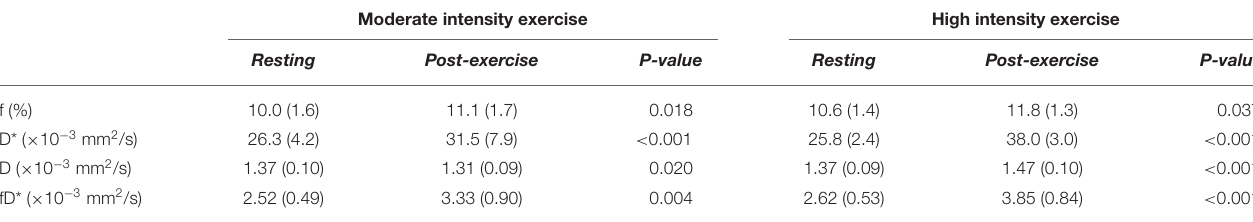
TABLE 2 | Results of IVIM coefficients at rest and in response to moderate and high intensity exercise. Moderate intensity exercise High intensity exercise Resting Post-exercise P-value Resting